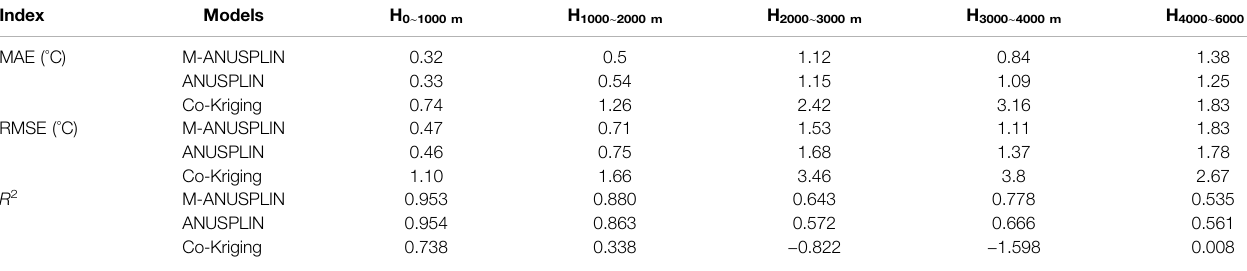
TABLE 3 | Accuracy metrics of co-kriging, ANUSPLIN, and M-ANUSPLIN for the different altitudinal